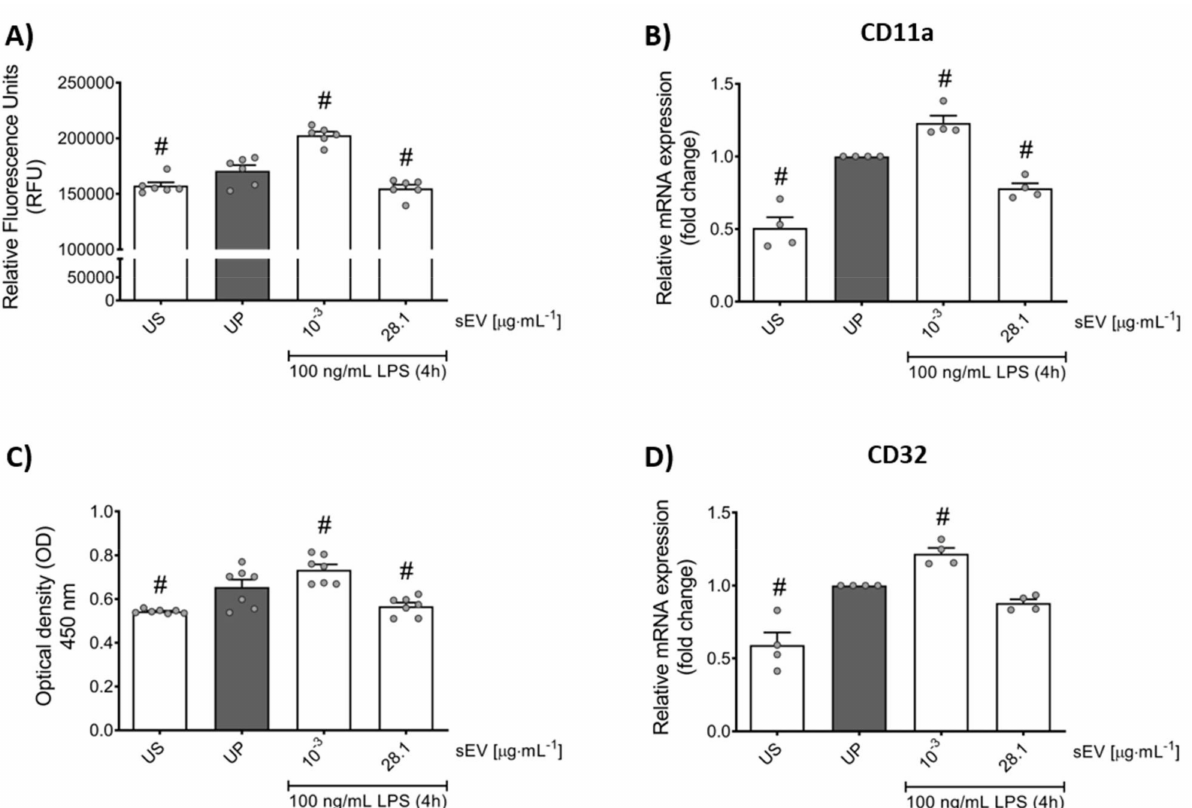
Figure 5. Microbiota-derived small EVs reshape migratory effects and phagocytic activity in murine neutrophils. Neutrophils were primed for 45 min by microbiota-derived small EVs (low concentration: 1 ng/mL; high concentration: 28,1 µ g/mL) and re-challenged by 100 ng/mL LPS for 4 h on day 2. Migratory activities of neutrophils ( A , n = 6) were analyzed using commercially available kits as described above and data were shown as relative fluorescence units (RFU), whereas real-time qPCR was used to analyze the gene expression of ( B ) CD11a ( n = 4) and ( D ) CD32 ( n = 4) (unprimed state assigned as 1.0). Phagocytic activity ( C , n = 7) of murine neutrophils was determined by commercially available kits as described above and data were expressed as optical density (OD) values. Data are presented as scatter dot plots, mean + SEM, # p < 0.05, # versus unprimed condition (UP, gray